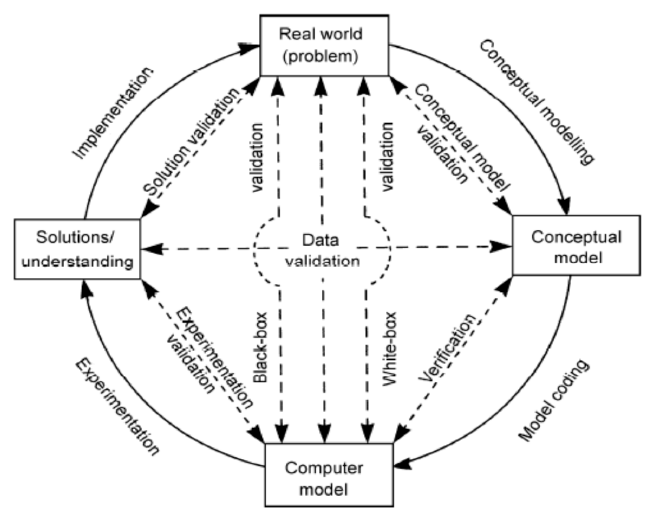
Figure 1. Simulation VV cycle [10].